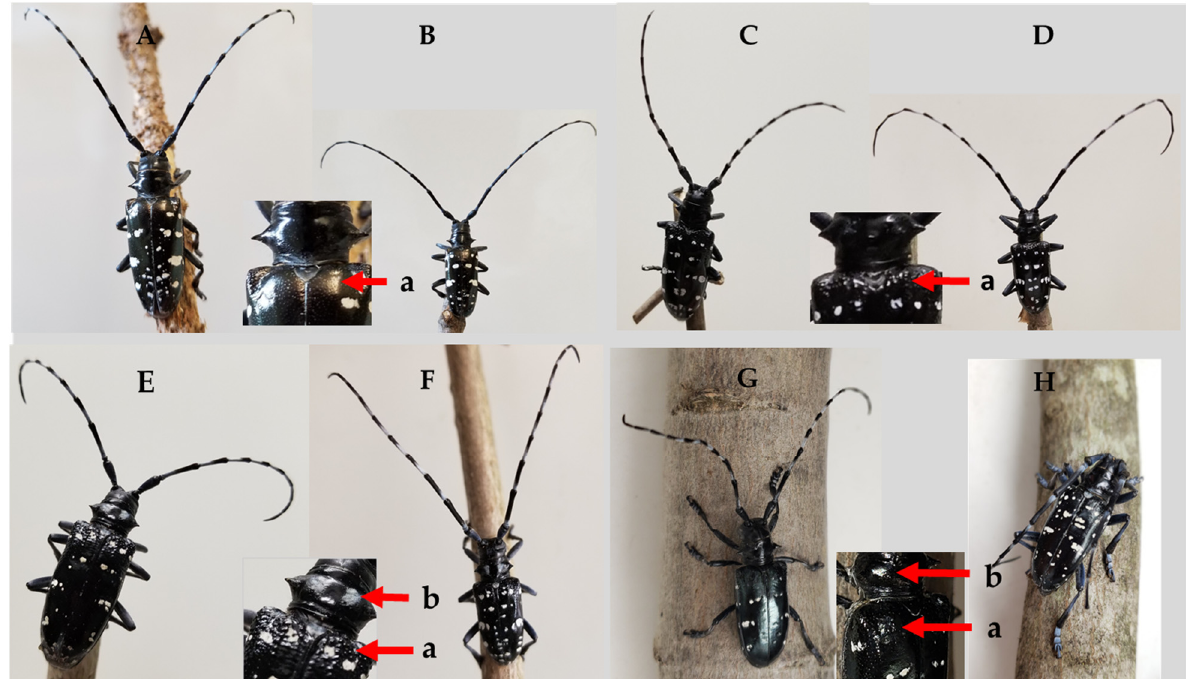
Figure 3. Adult female ( A ) and male ( B ) Anoplophora glabripennis (ALB), female ( C ) and male ( D ) A. chinensis (CLB), female ( E ) and male ( F ) A. malasiaca (JCLB), and female ( G ) and male ( H ) hybrids of ALB and JCLB. Arrows point to the smooth (ALB) or grainy (CLB, JCLB or the hybrid) surface of the basal portion of the elytra (a) or the presence of two white spots on the pronotum in JCLB or the hybrid (b).